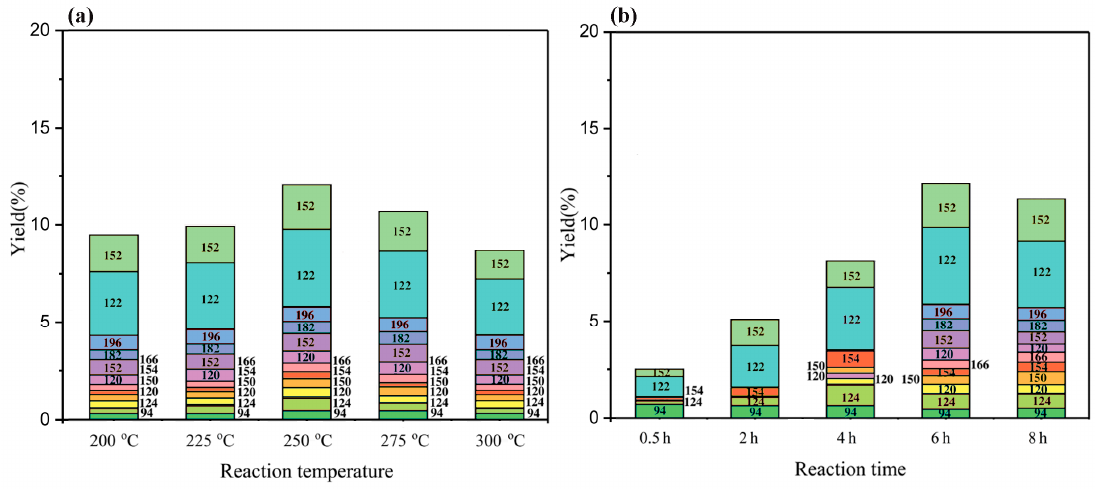
Figure 4. The monomeric yield distribution following the BL reaction under di ff erent reaction conditions. ( a ) The monomeric yield distribution following the BL reaction at di ff erent reaction temperatures for 6 h; ( b ) the monomeric yield distribution following the BL reaction at di ff erent reaction times for 250 °C.